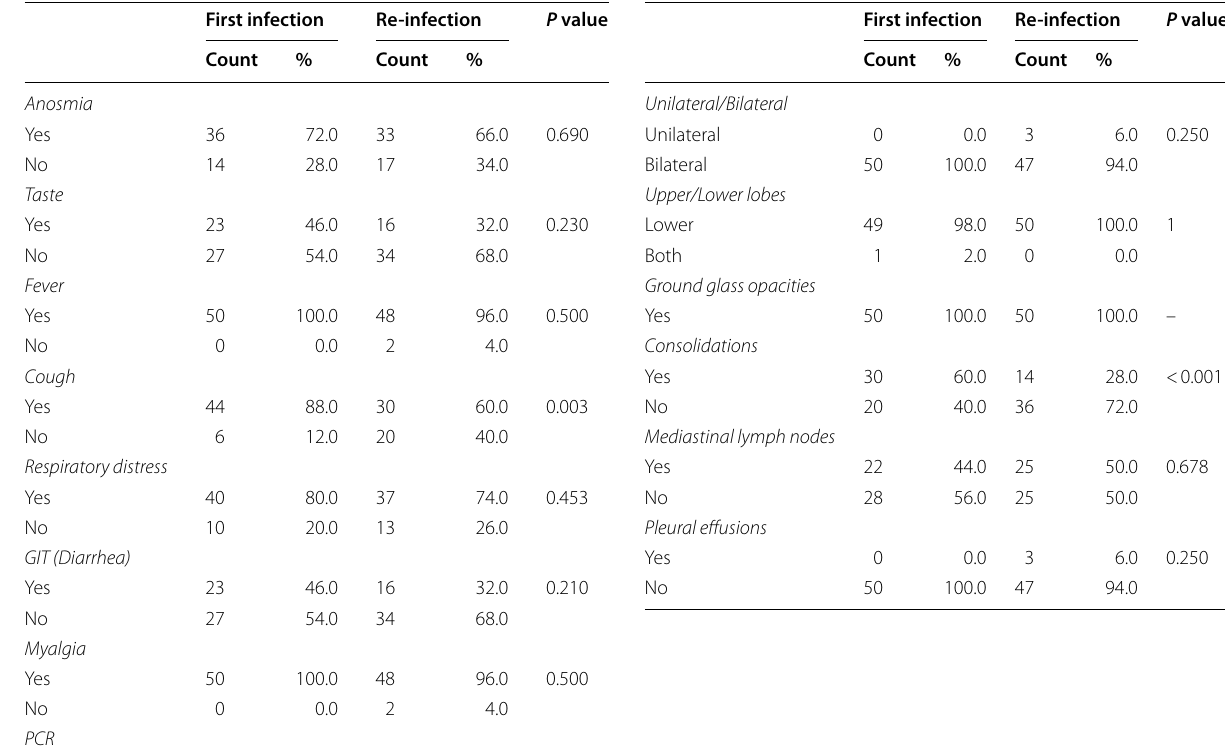
Table 4 Showed the radiological CT chest finding during